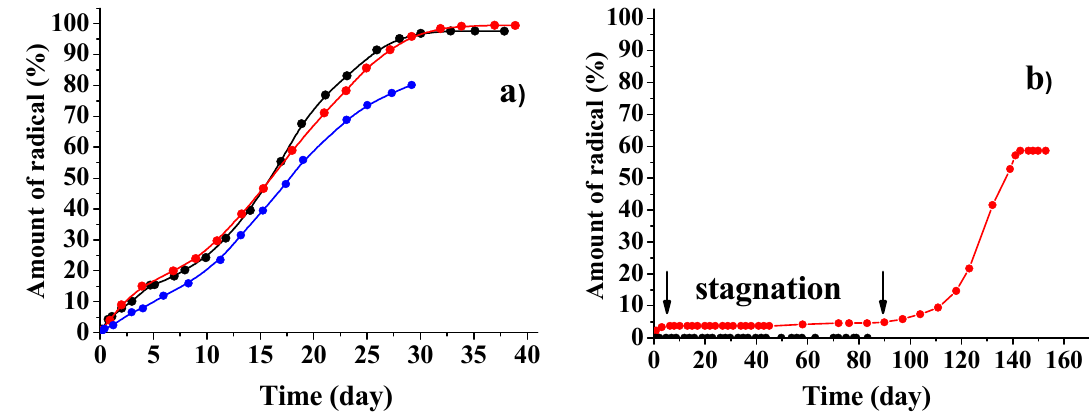
Figure 6. Kinetic curves corresponding to the release of TEMPOL (black and red symbols) and ATI (blue symbols) from PDL 02 films ( a ) and of sl-DCF (black symbols) and TEMPONE (red symbols) from PDL 04 films ( b ) into PBS: measurement errors are 10–12%. The lines are not the result of fitting.